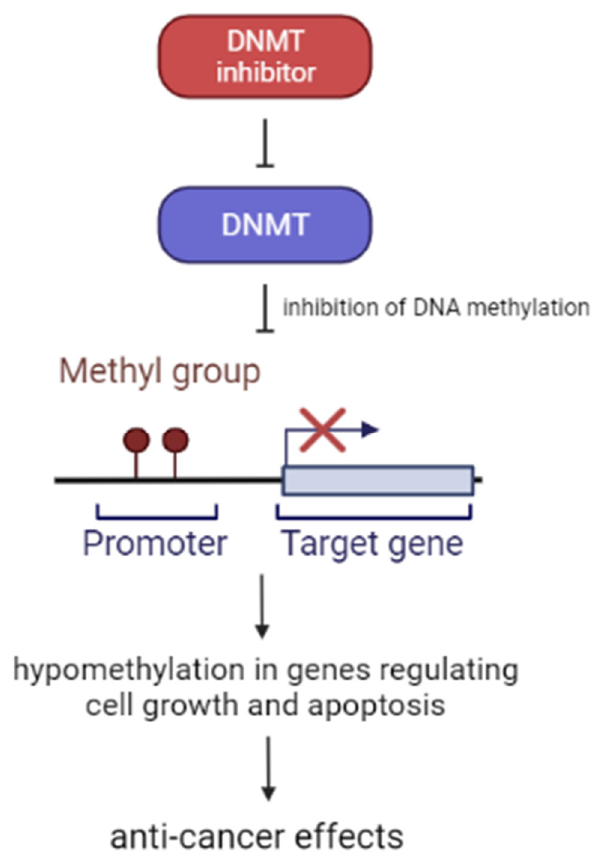
Figure 2. Effect of DMNT inhibitors application.